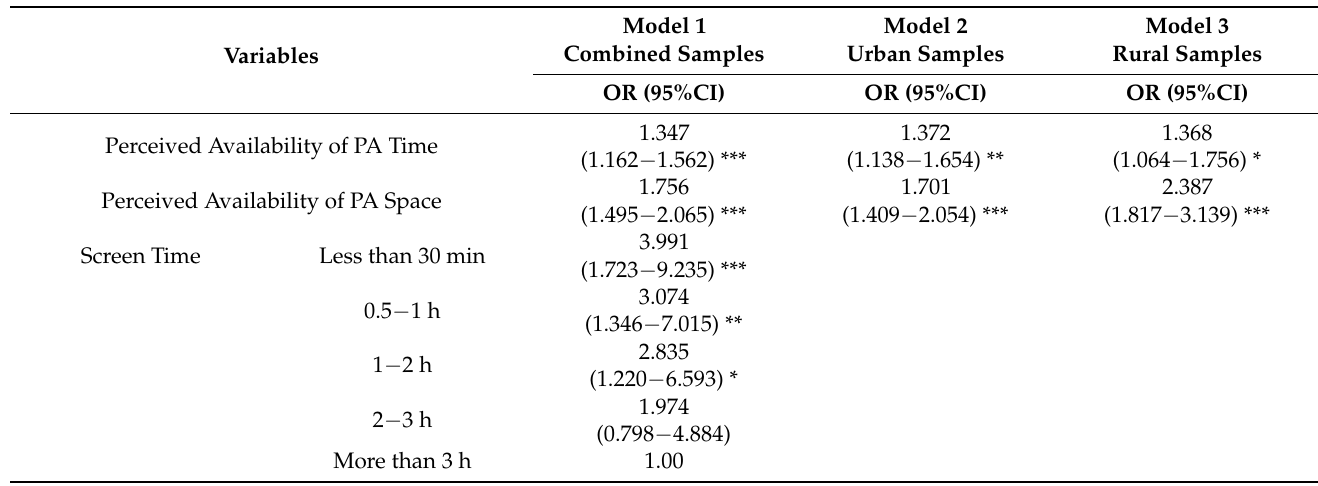
Table 6. Variables Predicting MPA Frequency: Results from Ordinal Logistic Regression Models.